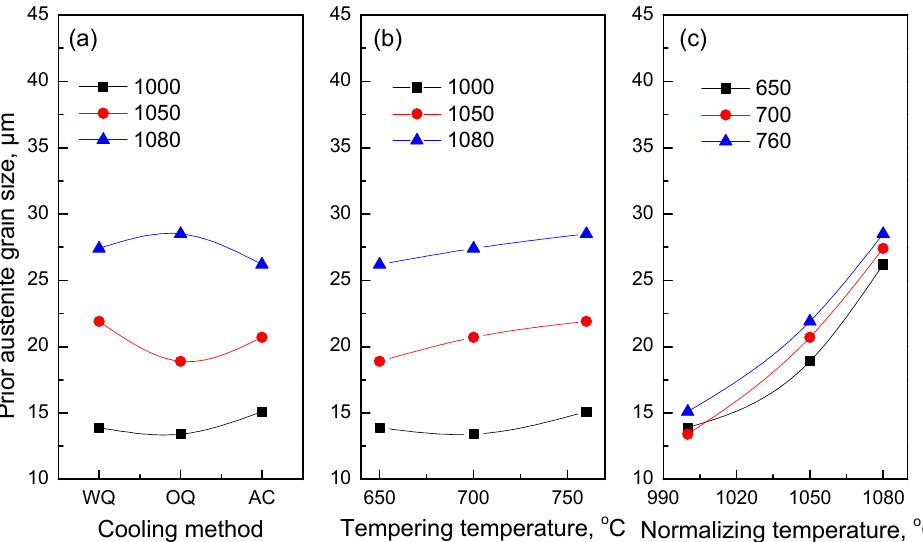
Figure 2. Average prior austenite grain (PAG) size of 15Cr12MoVWN steel with heat treatment parameters. ( a ): Cooling method; ( b ): Tempering temperature; ( c ): Normalizing temperature.